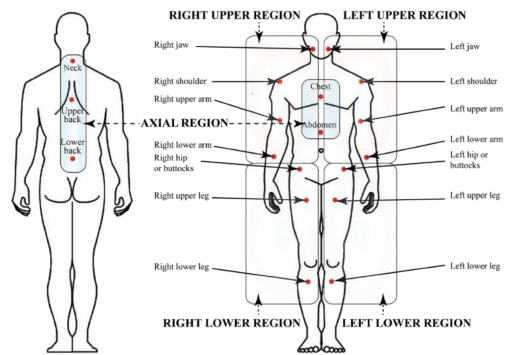
Figure 1. Widespread Pain Index from ACR 1990 criteria for the classification of fibromyalgia and related